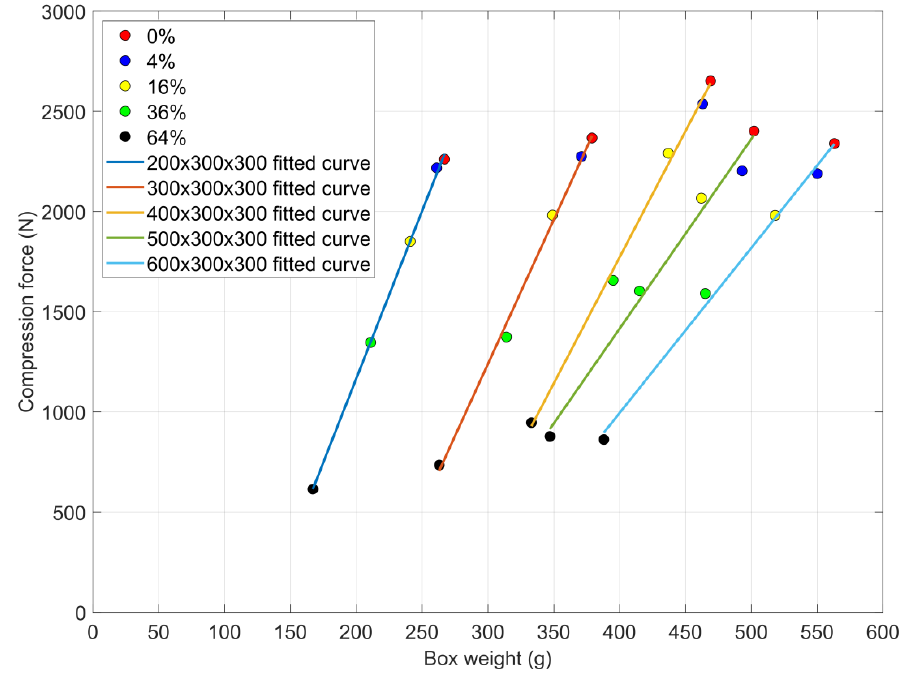
Figure 7. Box weights and averages of maximum compression forces diagram along the various cutouts. ous